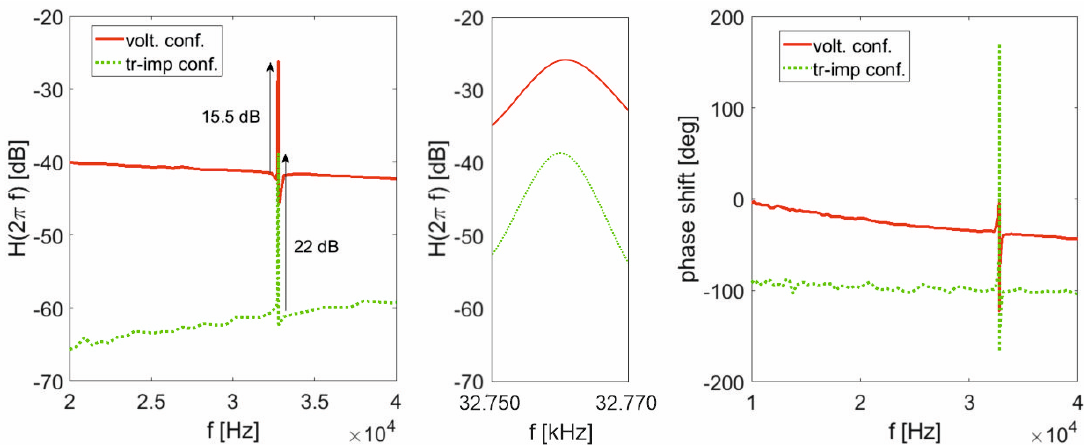
Figure 4. Frequency response of the QEPAS sensor with the preamplifier working in transimpedance and voltage configurations: amplitude ( left ), amplitude zoomed around the resonance frequency ( middle ) and phase ( right ) measured with the frequency resolution better than 0.1 Hz.